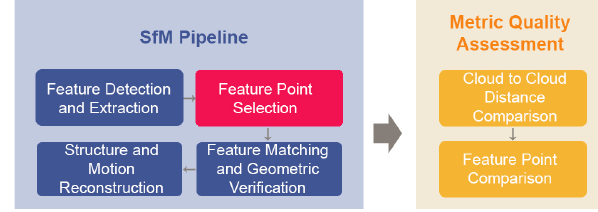
Figure 1. Flowchart of the proposed